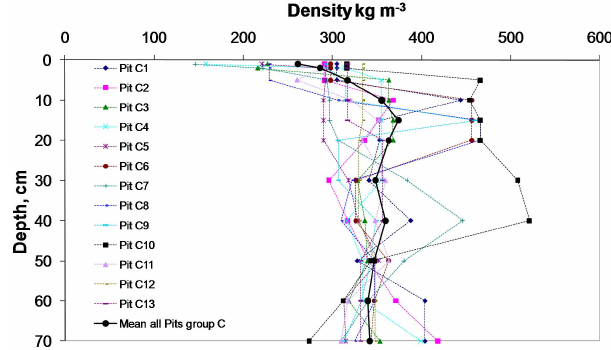
Fig. 5. Density profiles of group C pits at Dome